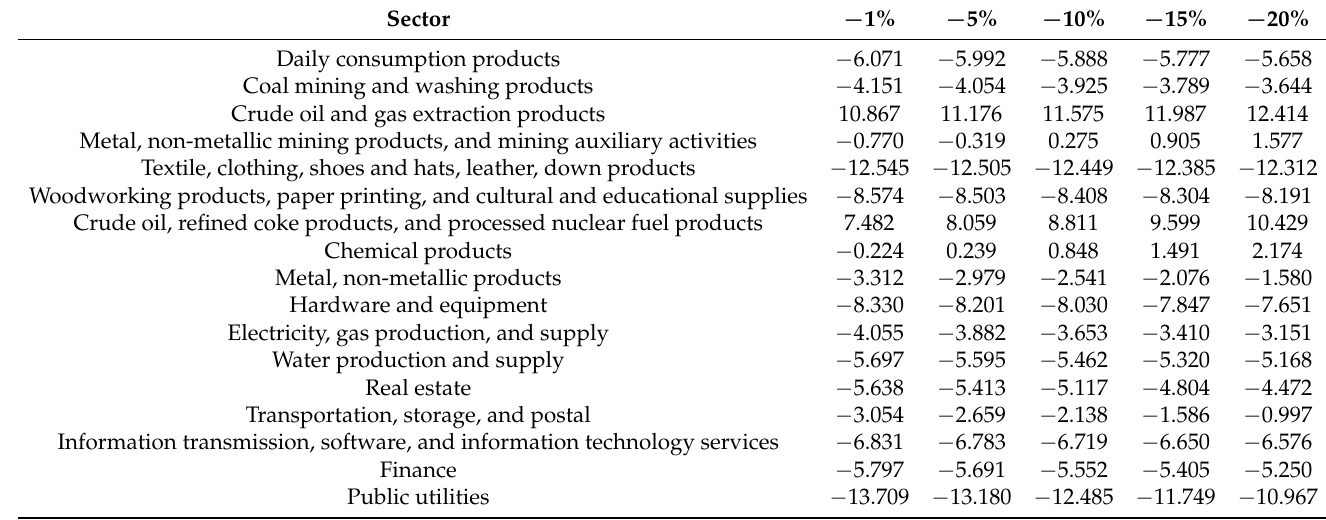
Table A16. The rate of change in investment after the decline in crude oil